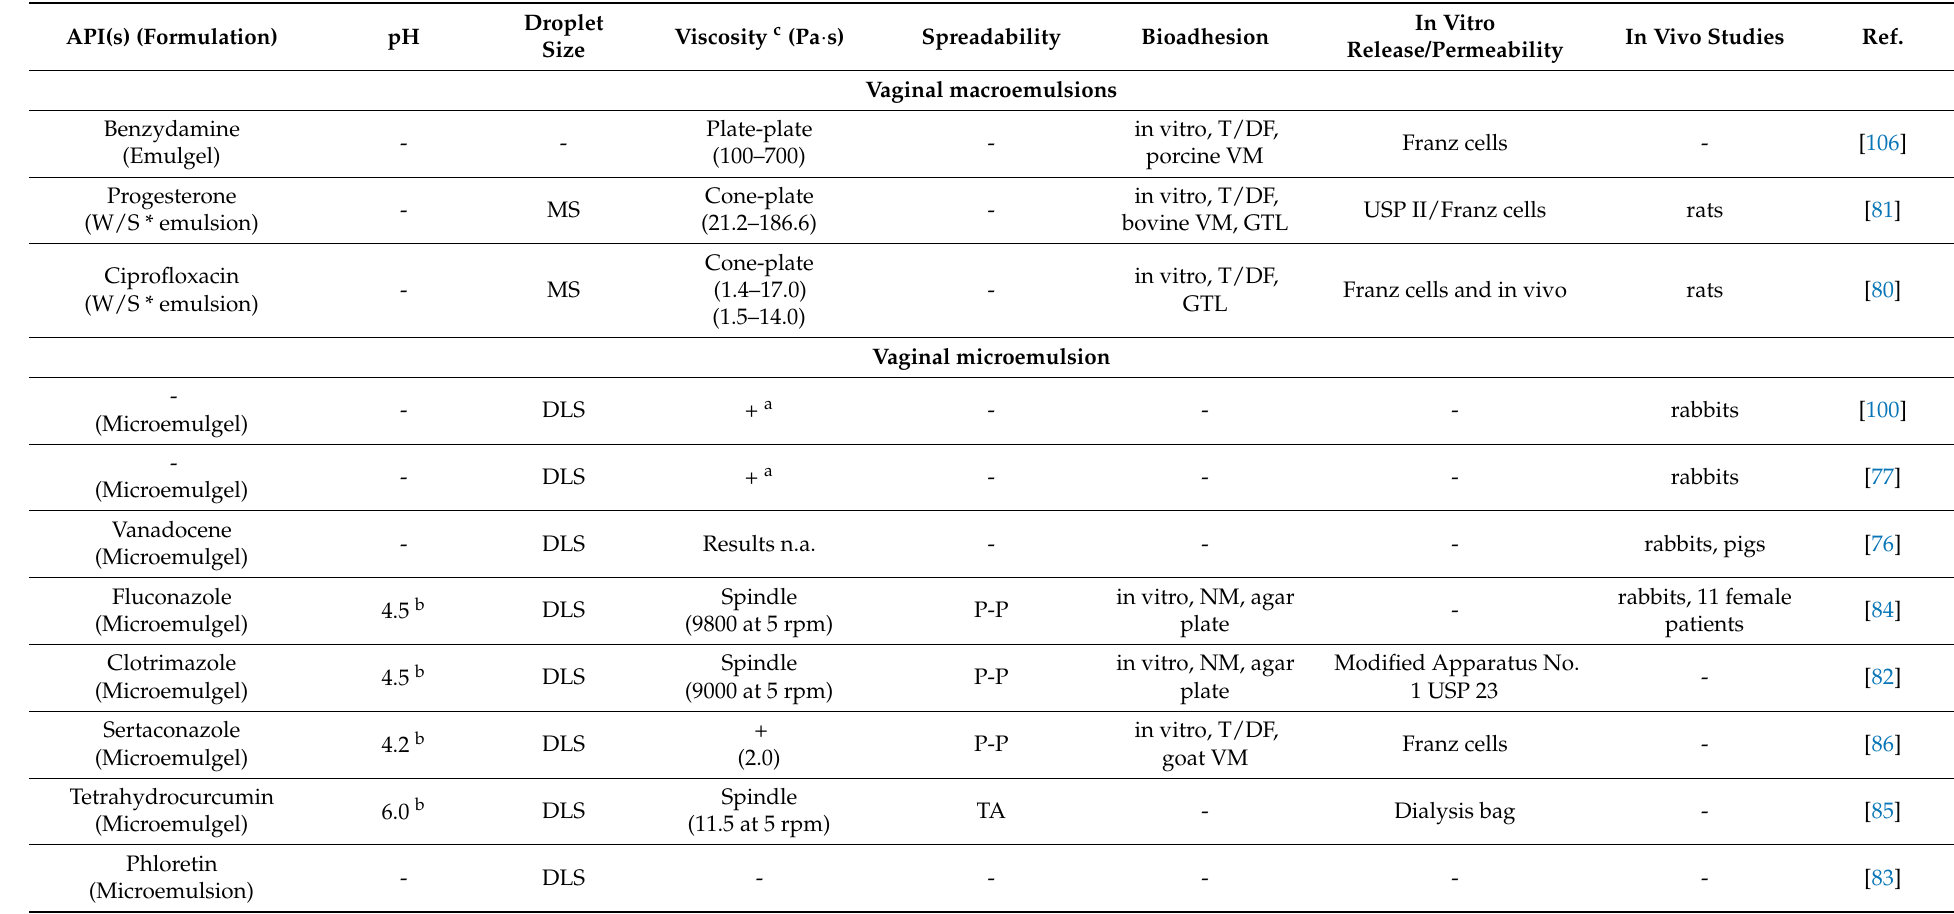
Table 7. Comparison of parameters and research methods using in evaluation of emulsion-based vaginal dosage forms